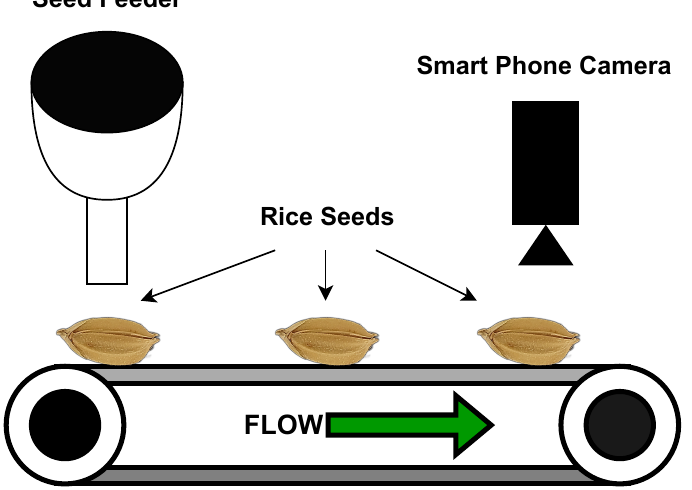
Figure 1. Rice seeds dataset construction setup.